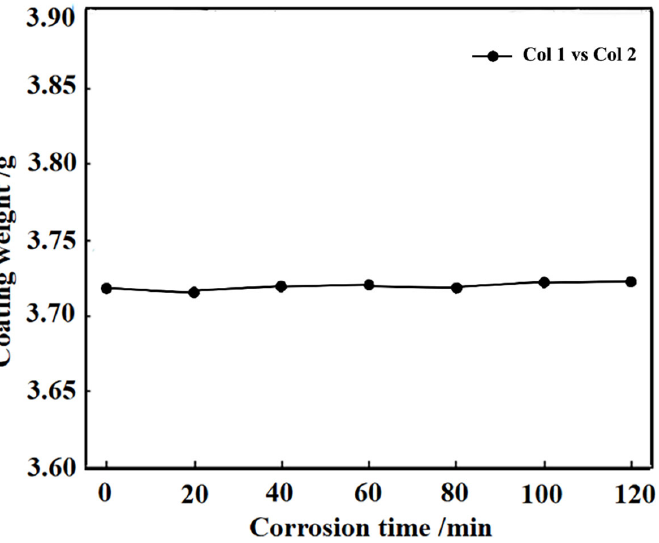
Figure 5. Variation curve of TiB 2 coating quality with erosion time after aluminum alloy erosion.